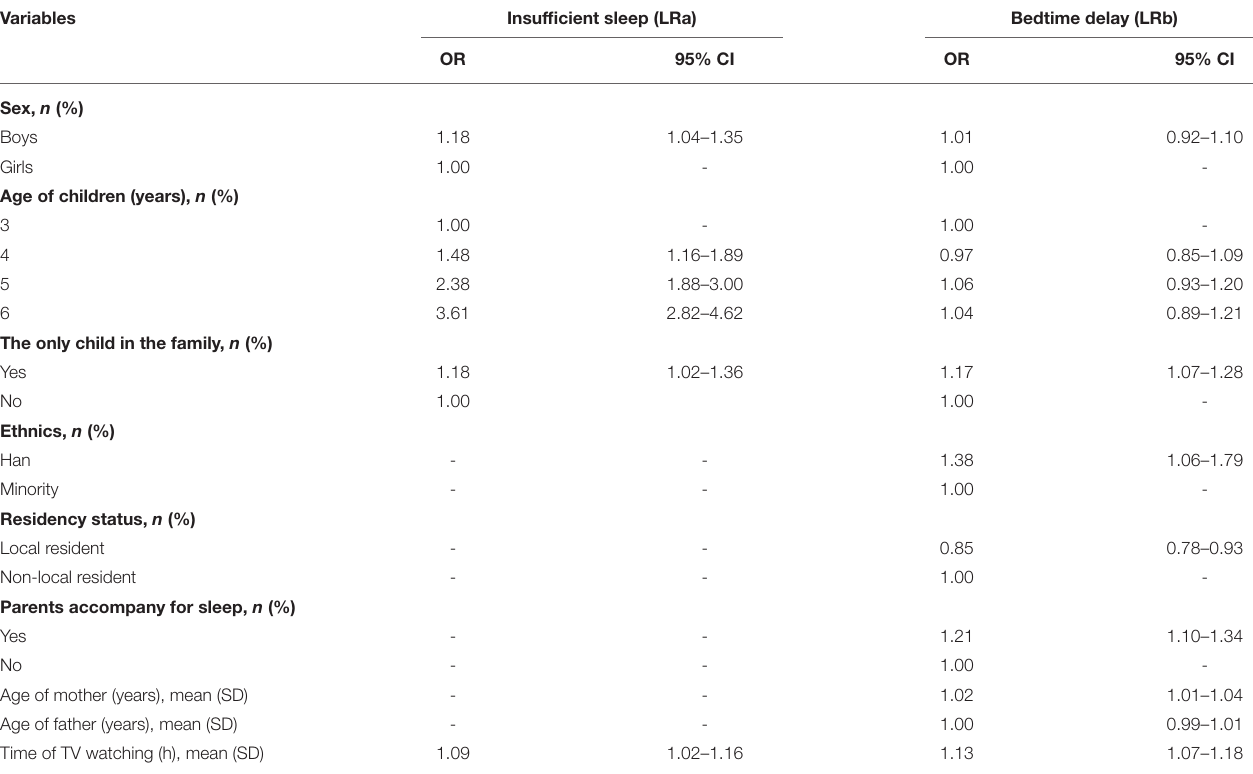
TABLE 3 | The influencing factors for bedtime delay and insufficient sleep among children aged 3–6 years in a rural area of Shanghai, China, in the year 2018. Variables Insufficient sleep (LRa) Bedtime delay